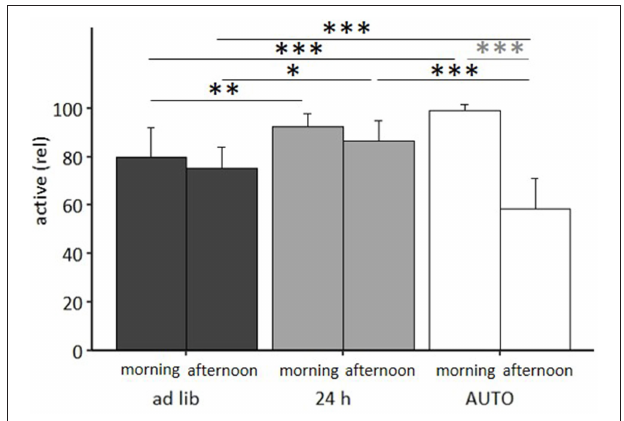
FIGURE 9 | Activity in the home cage. Ad lib , Ad libitum group; 24h, 24h schedule group; AUTO, Automated feeding routine group. Data presented as